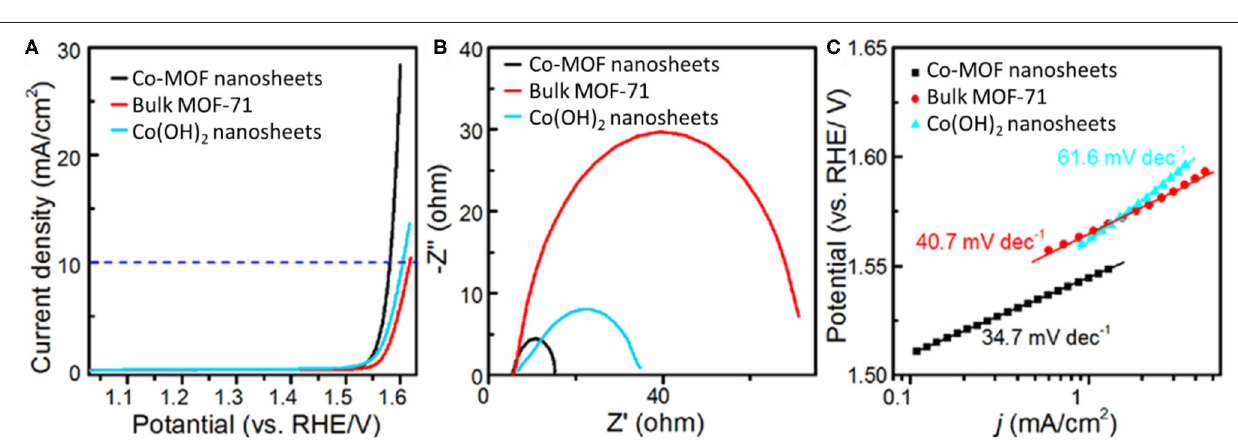
density increased by about 1.37 mA cm − 2 under